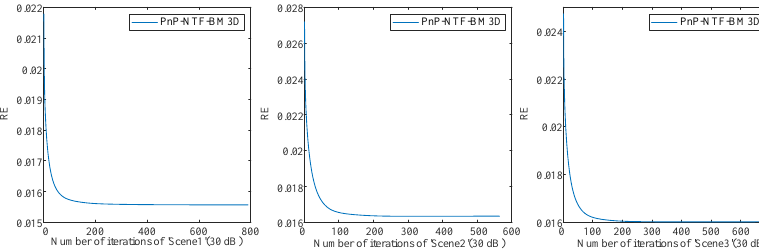
Figure 6. Evaluation results of RMSE with the proposed method and state-of-the-art methods on ‘Scene3’.